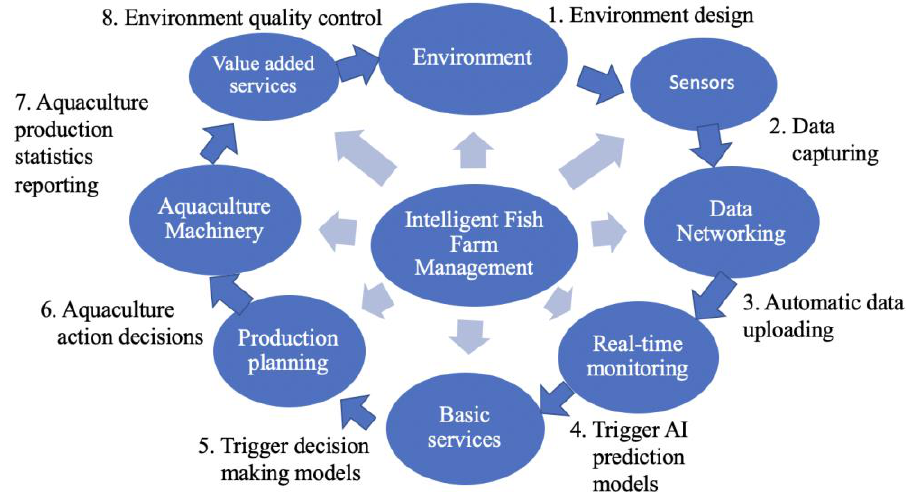
Figure 6. The automatic workflow of the AIoT information system for intelligent fish farm manage‑ ment.